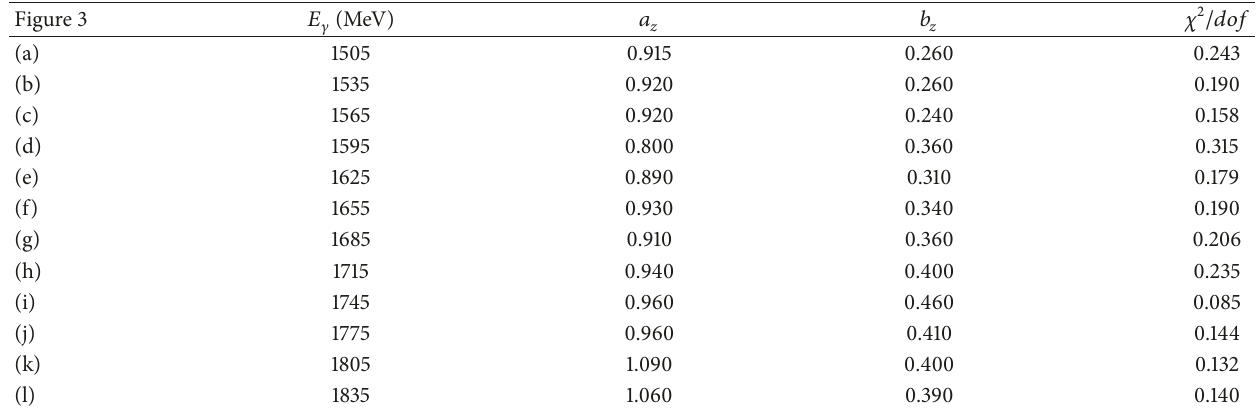
Table 3: Values of 𝑎 𝑧 and 𝑏 𝑧 taken in Figure 3 model